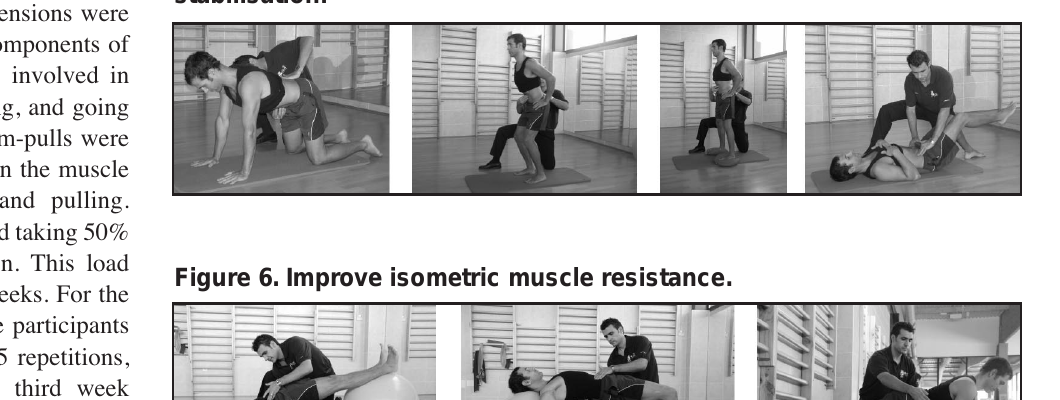
Figure 5. Improvement of motor control of the local system of lumbar stabilisation.